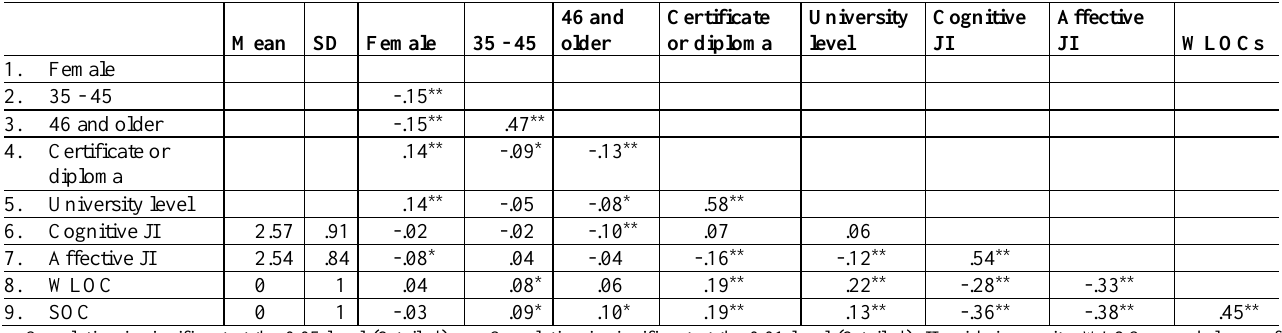
Table 2: Descriptive statistics and bivariate correlations